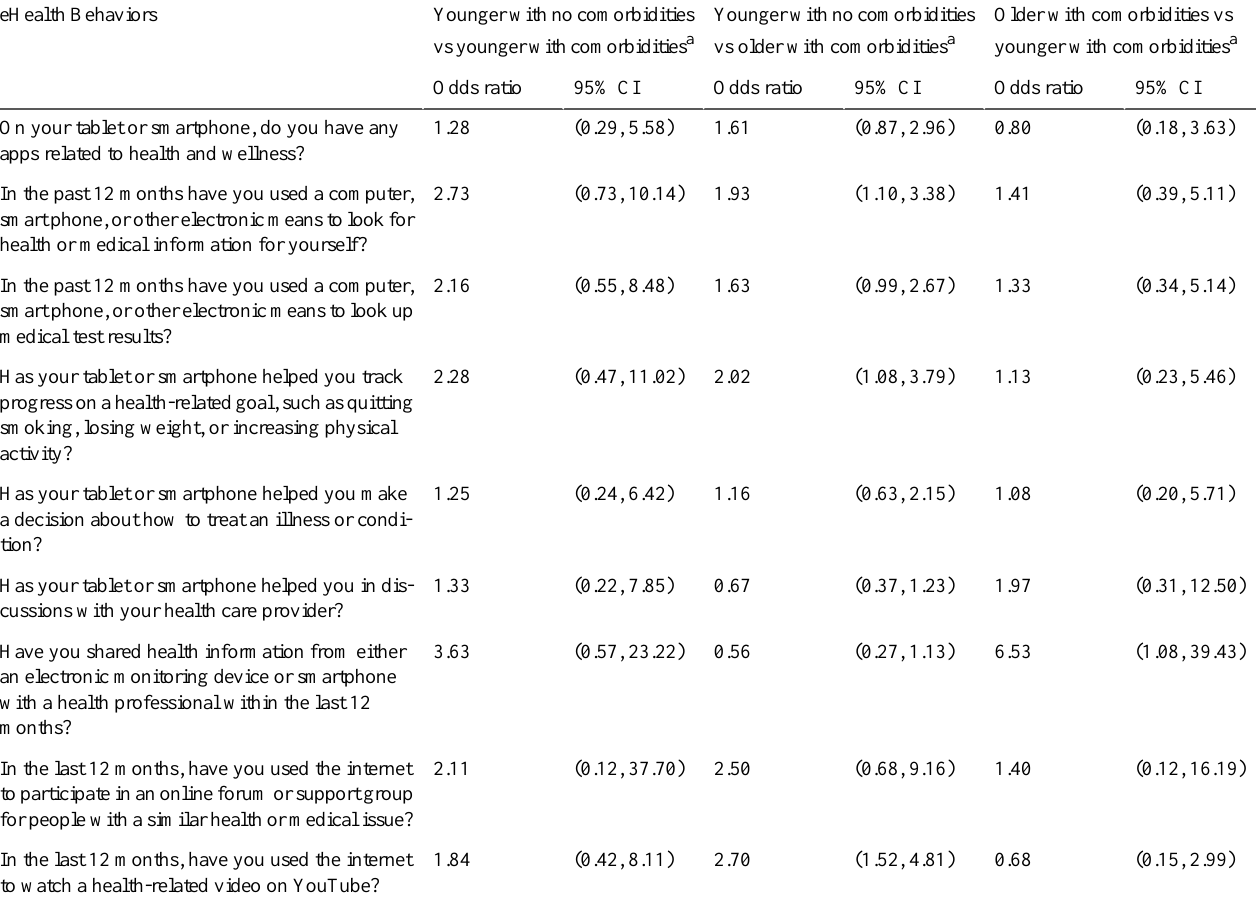
Table 3. Logistic regression models predicting eHealth behaviors using latent classes as predictors.